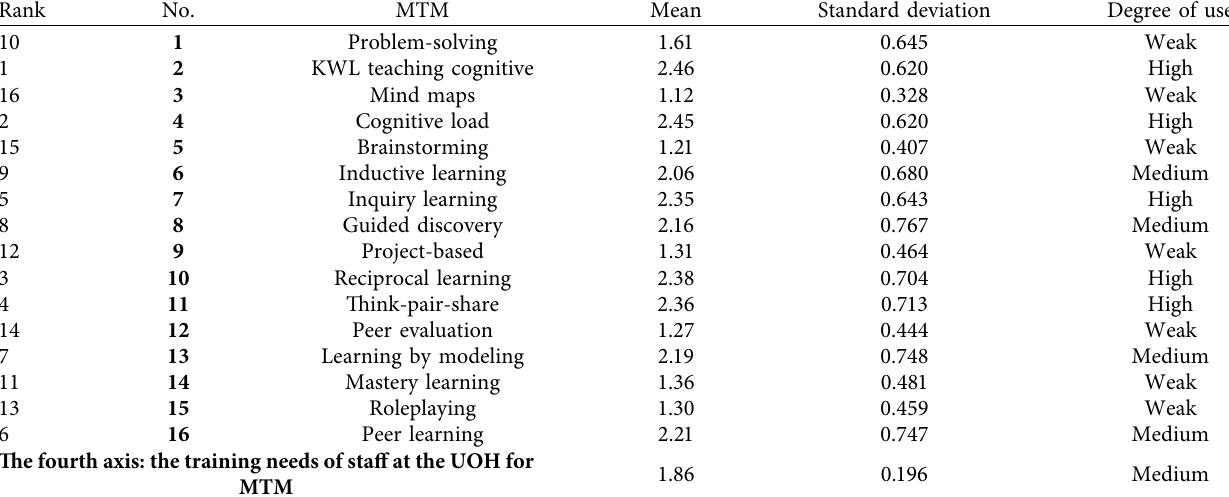
Table 8: Averages and standard deviations of the questionnaire paragraphs in the fourth axis: the training needs of staff at the UOH for